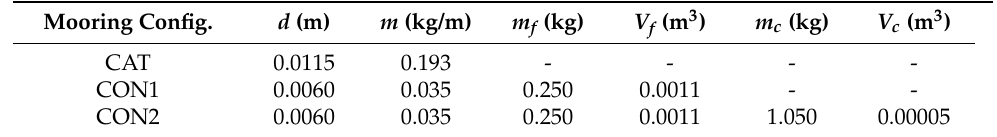
Table 2. Static properties of mooring cables.